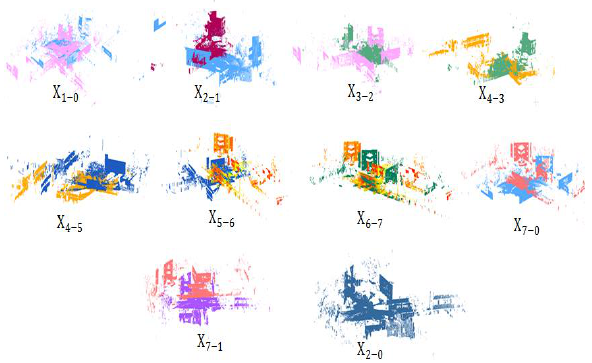
Figure 5. Pairs of point clouds used in the pairwise registration.